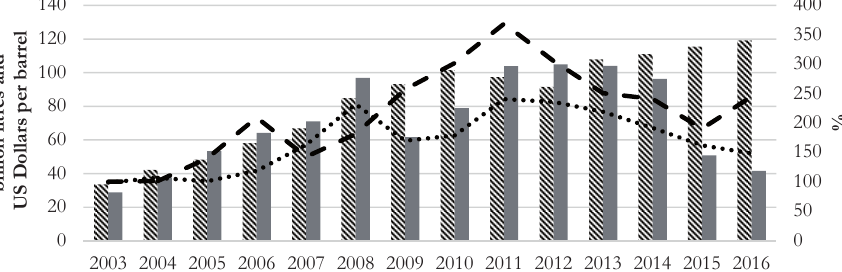
Fig. 4 – Word ethanol production, crude oil price, cereals and sugar price index (2003-2016). Source: OECD/ FAO (2017b), FAO (2016), World Bank